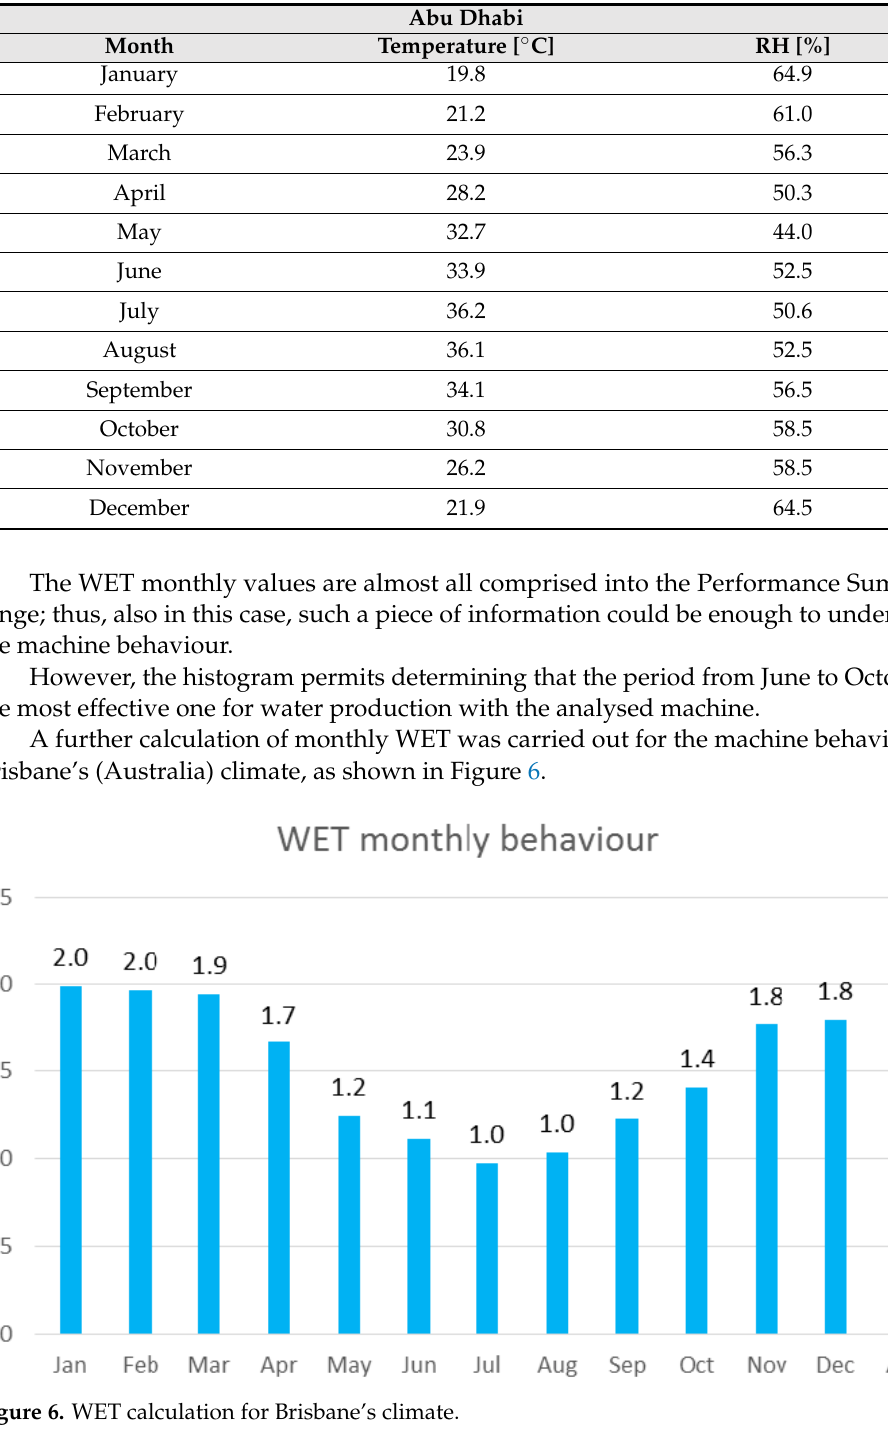
Table 10. Average weather data in Abu Dhabi.